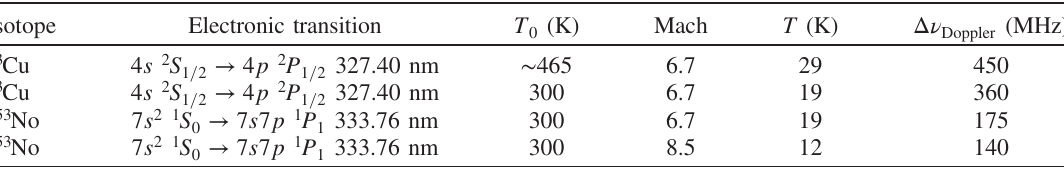
TABLE III. Projected spectral linewidth of the in-gas-jet laser ionization and spectroscopy technique as, e.g., implemented in the S 3 -LEB setup